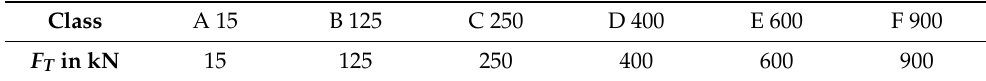
Table 2. Test loads of the hatch according to EN 124-1.